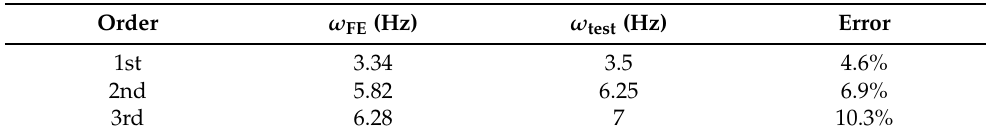
Table 3. Comparison between ω FE and ω test